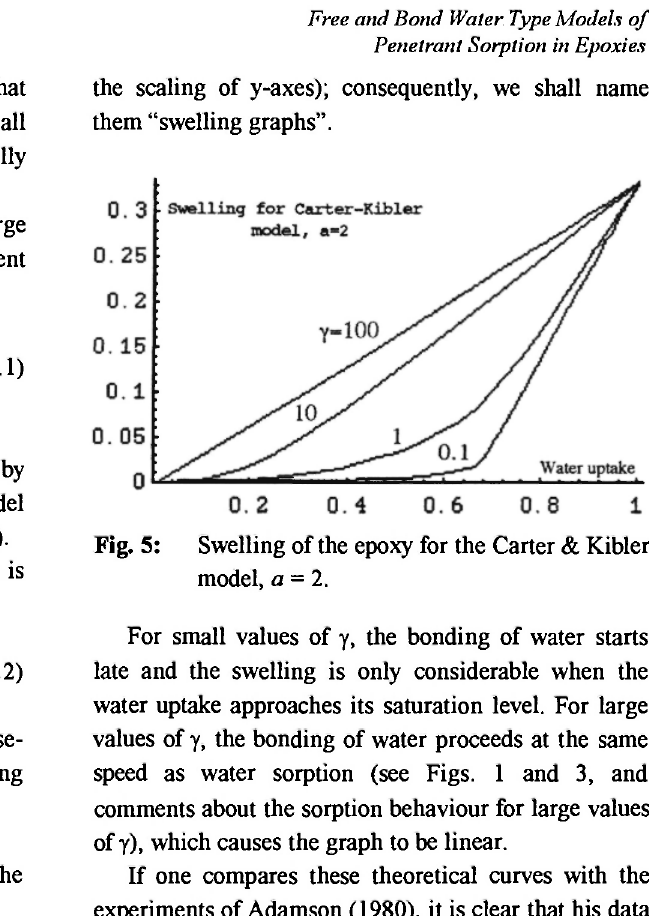
Fig. 5: Swelling of the epoxy for the Carter & Kibler model, a =